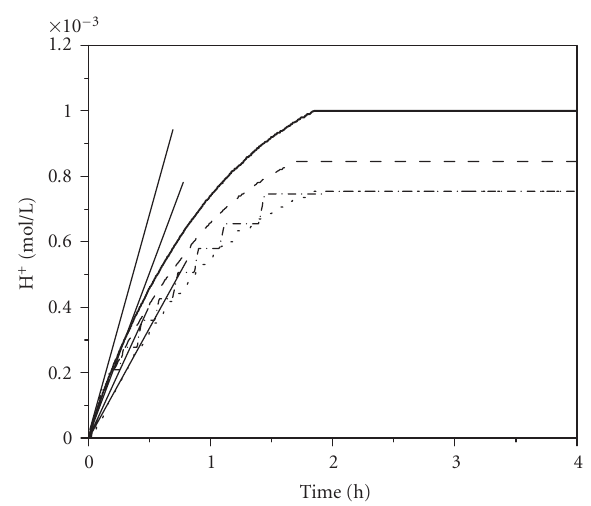
Figure 4: Degradation of DCA (shown as release of H + ) using the prepared colloidal TiO 2 photocatalyst at pH 3 in 3 consecutive runs without intermittent washing between runs, 1st run (—), 2nd run (–––), 3rd run ( ··· ), a 3rd run (- · -) with addition of 4mM Cl − before the run started, and slope ( ) used for the determination of the photonic e ffi ciency of each run with I ≈ 3 . 39 × 10 − 2 Einstein L − 1 h − 1 . The photocatalyst loading was 0.5 g/L.